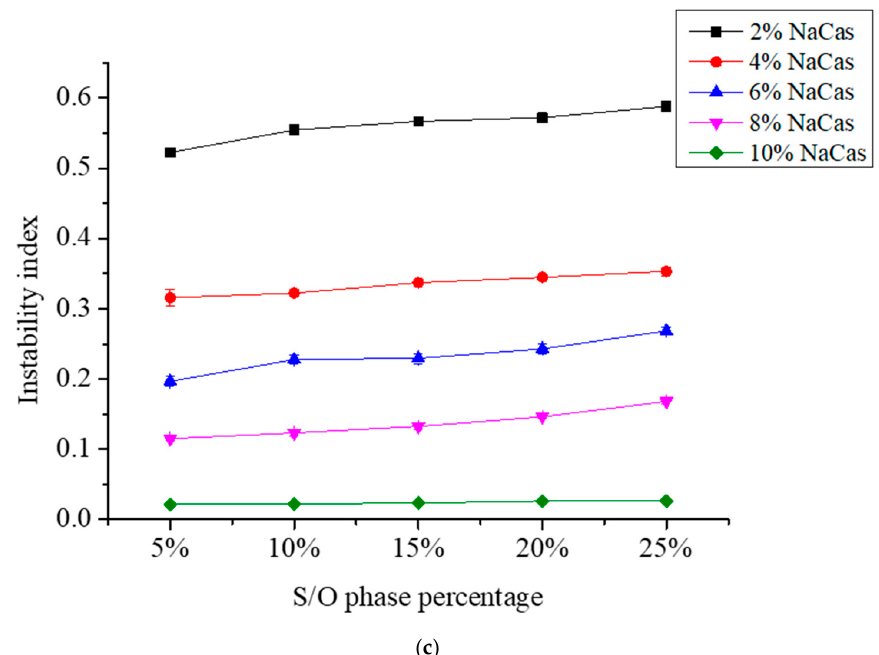
Figure 2. The zeta potential; ( a ) particle size distribution; ( b ) and instability index; ( c ) of S/O/W emulsions at different concentrations of NaCas and different proportions of S/O phase; (A, 2 wt% NaCas; B, 4 wt% NaCas; C, 6 wt% NaCas; D, 8 wt% NaCas; E, 10 wt% NaCas).